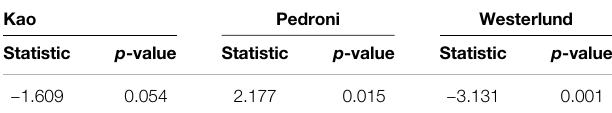
TABLE 3 | Panel cointegration